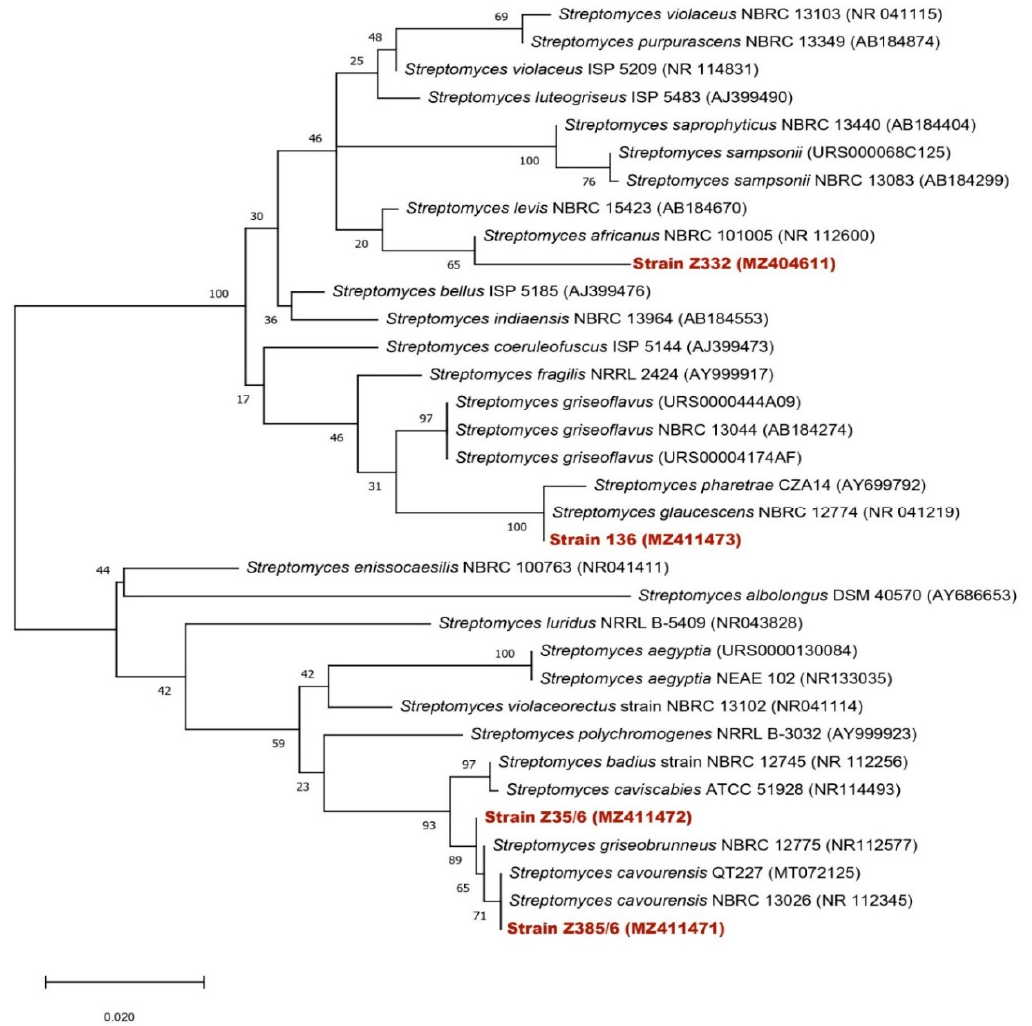
Figure 1. Neighbor-joining phylogenetic tree of the four isolated strains and 30 Streptomyces species based on nearly complete 16S rRNA gene sequences (1400 nt). Numbers at nodes indicate levels of bootstrap support (%) based on a neighbor-joining analysis of 1000 resampled datasets. Accession numbers are given in parentheses. Bar, 0.02 nucleotide substitutions per site.